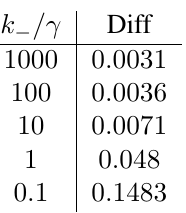
TABLE I: The (cid:96) 2 distance between the quasi- steady state approximation and the exact distribu- tion estimated by stochastic